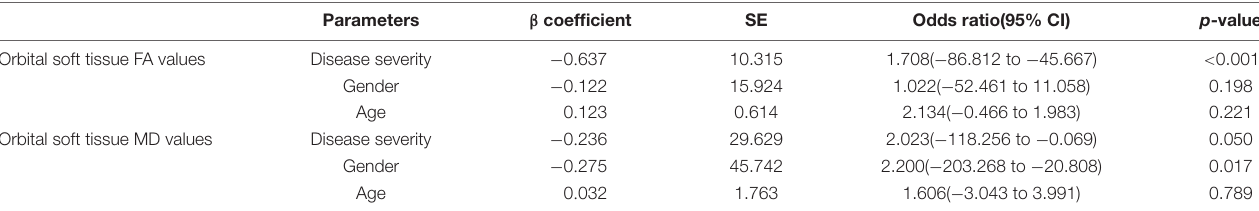
TABLE 6 | Multivariate logistic regression analysis results for predicting impact to orbital soft tissue DTI